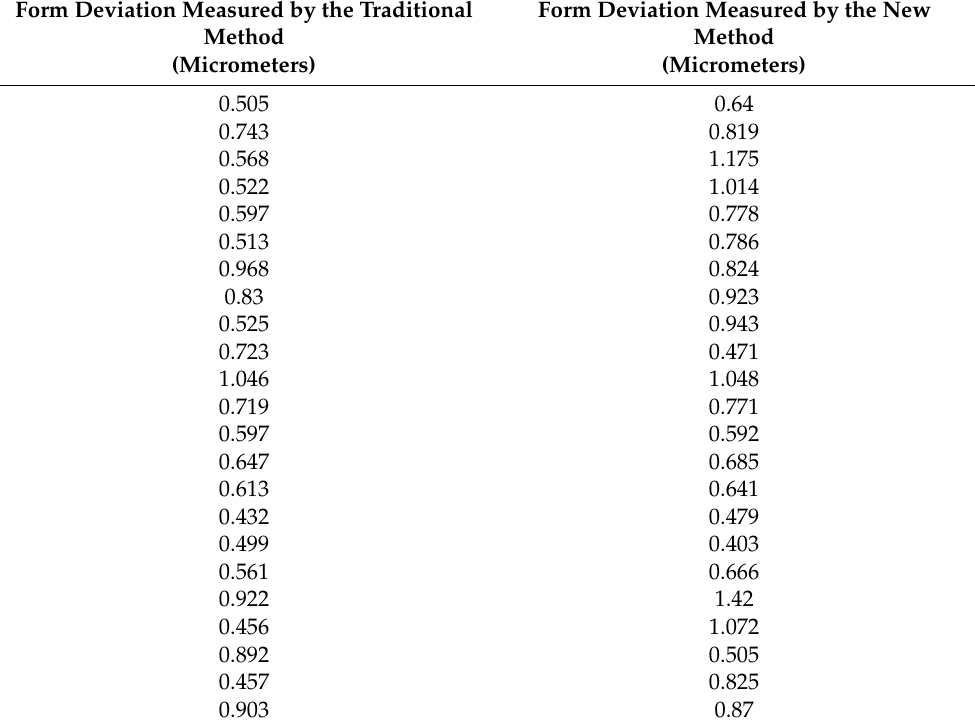
Form Deviation Measured by the